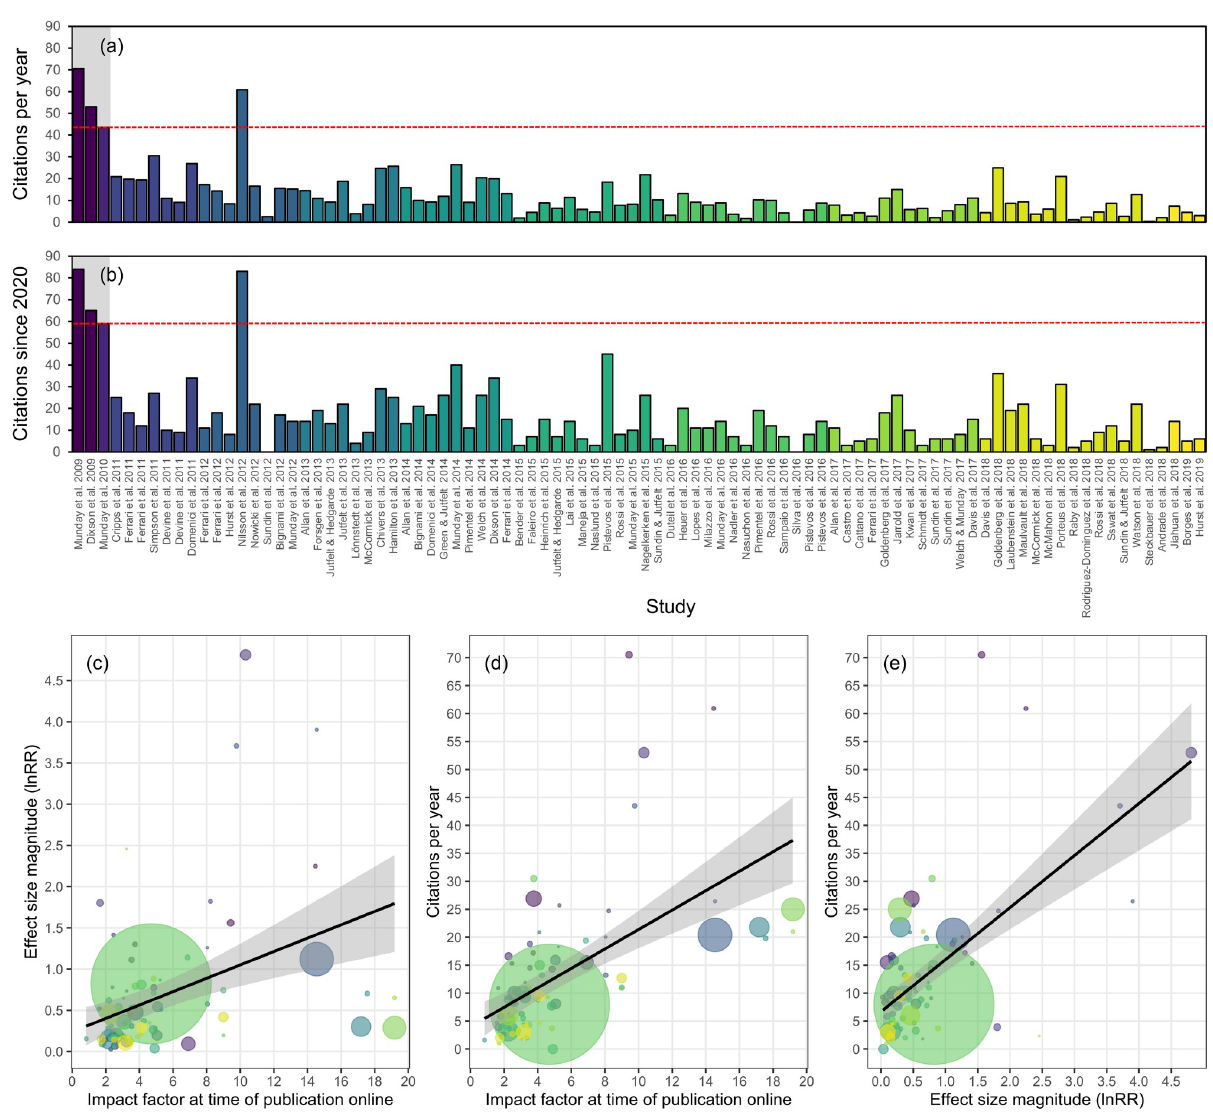
Fig 4. Strong effects are published in high-impact journals, and these studies are cited more than small effect studies in lower-impact journals. (a, b) Google Scholar citation metrics as of September 10, 2021 for each of the studies included in our meta-analysis, including average citations per year (a) and total citations since 2020 (b). The initial 3 studies spearheading this field are denoted by the gray background, and the red dashed line represents the lowest citation metric among those 3 studies. Studies are ordered chronologically along the x-axis and color coded by year published online. (c) Mean effect size magnitude for each individual study as a function of journal impact factor (at time of online publication). (d) The number of citations per year for each study as a function of journal impact factor (at time of online publication). (e) The number of citations per year for each study as a function of mean effect size magnitude for that study. Note that, for panels (c) and (e), mean effect size magnitude for a given study is not a weighted effect size magnitude, but is simply computed as the mean of individual effect size magnitudes for a given study. Data are fit with linear curves and 95% confidence bounds, and points are color coded by study; the size of data points represents the relative mean sample size of the study. Source data for each figure panel can be found in S1